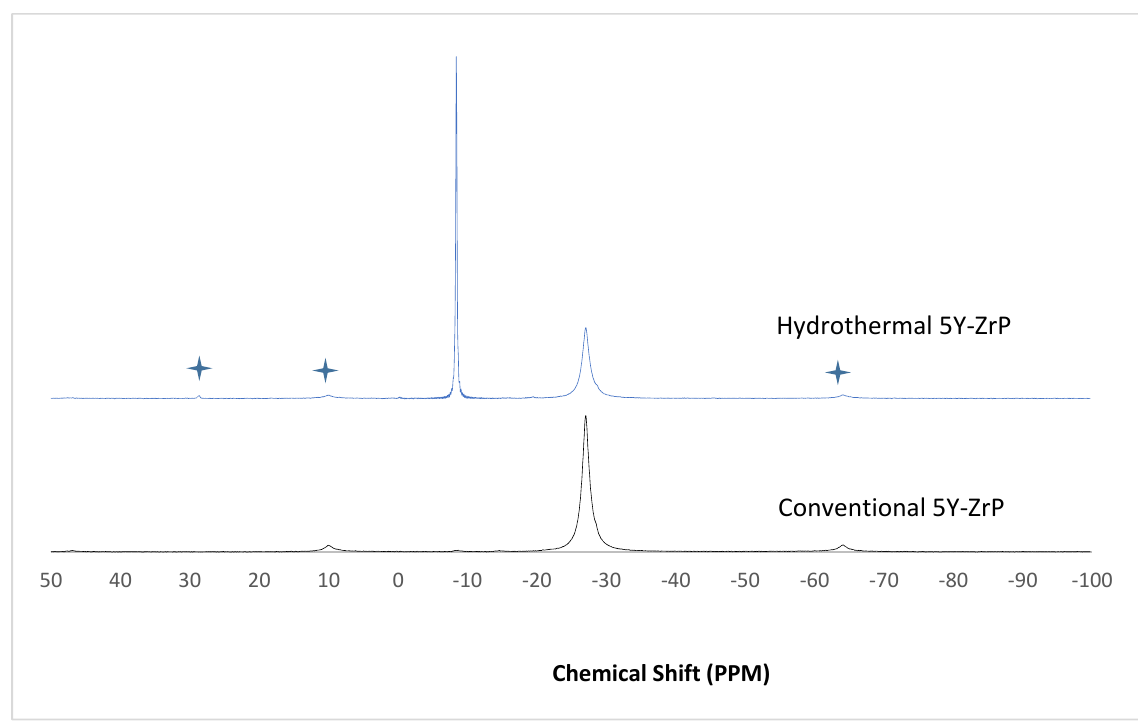
Figure 7. 31 P NMR of 5Y-ZrP synthesised using the two described methods (spinning side bands are shown as ).